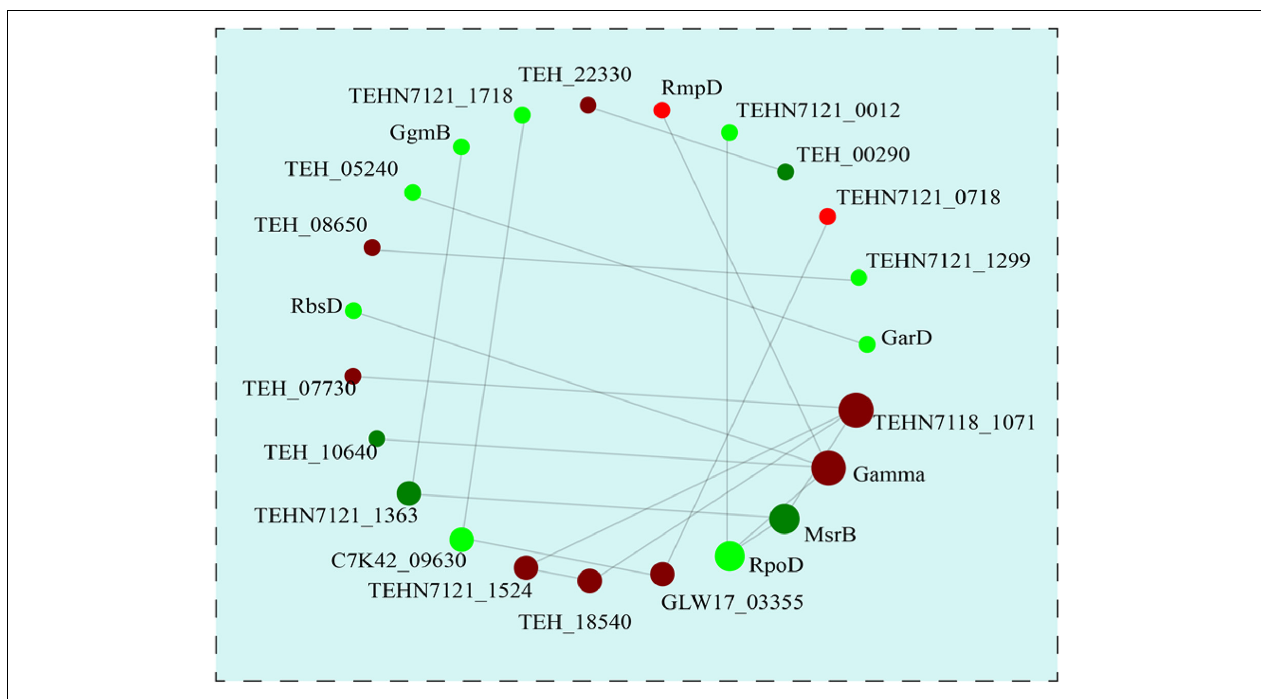
FIGURE 7 | The protein-protein interaction network analysis of the differentially expressed proteins. With the fold change > 1.2 or < 0.83, all the 23 differentially DEPs were used for PPI analysis. The up- and down-regulated proteins after heat preadaptation are shown in red and green,